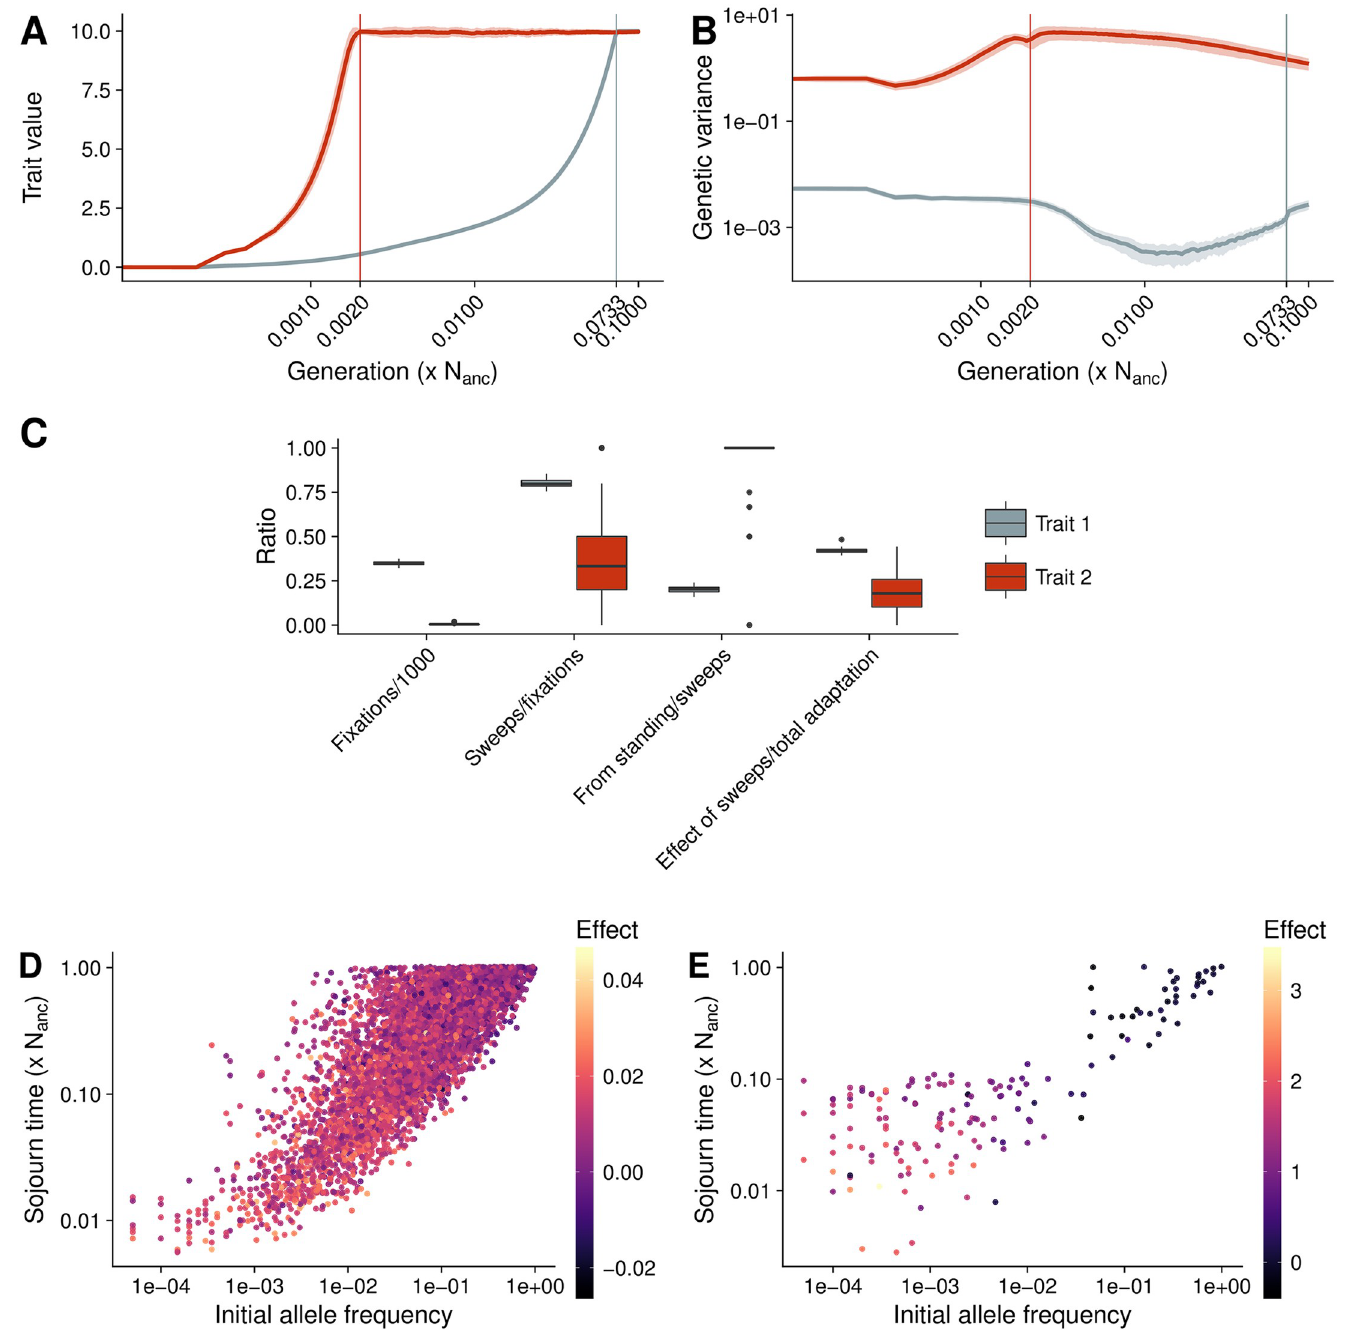
Fig 6. Maize specific adaptation. A ) The evolution of trait value and B ) genetic variance during adaptation to a new trait optimum for two traits under maize demography with no genetic background. Time in both figures is shown on a log scale, light shadows show standard deviations from the mean of 100 simulation replicates. Trait 1 (blue) has small effect mutations ( σ = 0.01) and strong stabilizing selection ( V = 1). Trait 2 (red) has large effect new mutations ( σ = 0.9) and weak m S m stabilizing selection ( V S = 50). Vertical lines denote the generation when 99% of the new trait optimum is reached. C ) Proportion of selective sweeps. D ) Sojourn time of sweeps from standing variation in Trait 1. E ) Sojourn time of sweeps from standing variation in Trait 2. Scales in D and E are different due to strong divergence of effect size